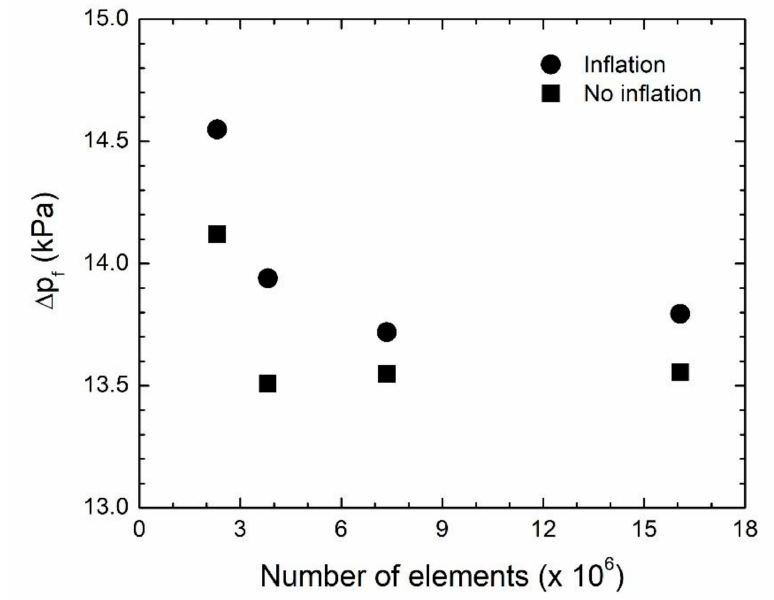
Figure 4. Filter pressure drop simulated with Ergun equation using grids of different element size with and without inflation layers. SS2 granular media and volumetric flow equal to 0.4 L s − 1